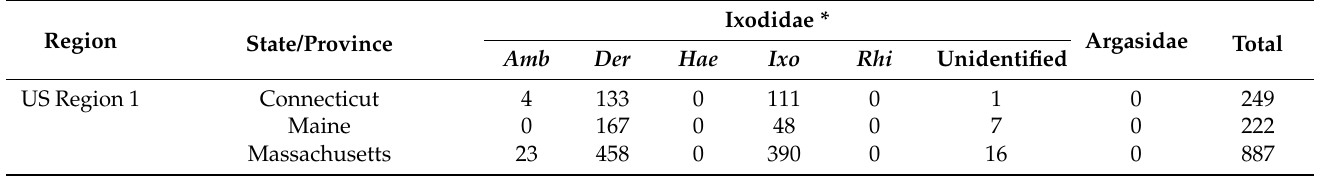
Table 1. Summary of iNaturalist tick observations by region, state/province, Family, and Genus.